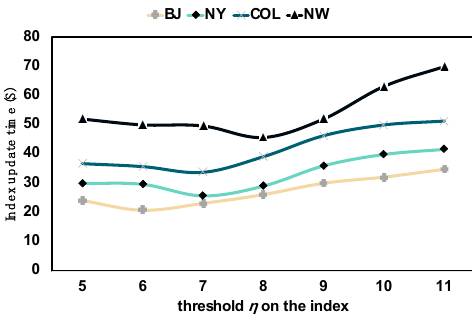
Figure 12. Index update time of DVTG-Index w.r.t. η .